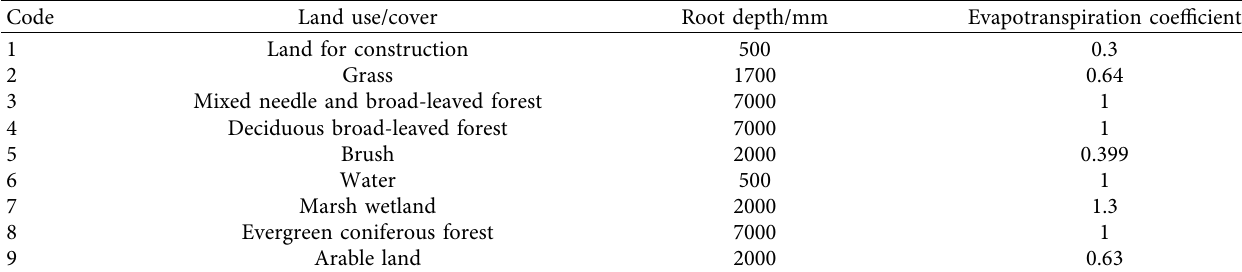
Table 2: Root depth and evapotranspiration coefficient in the study area.